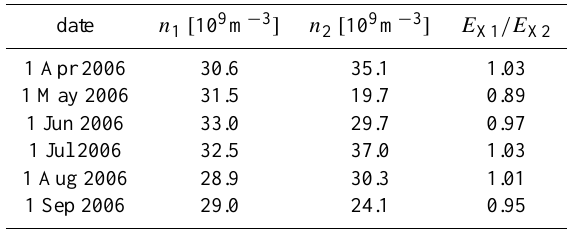
Table 2. Characteristic plasma densities obtained from the IRI 2007 model at altitude 660km over the middle Europe and corresponding ratios of the calculated electric field intensities (index 1 refers to daytime cases, 2 to nighttime